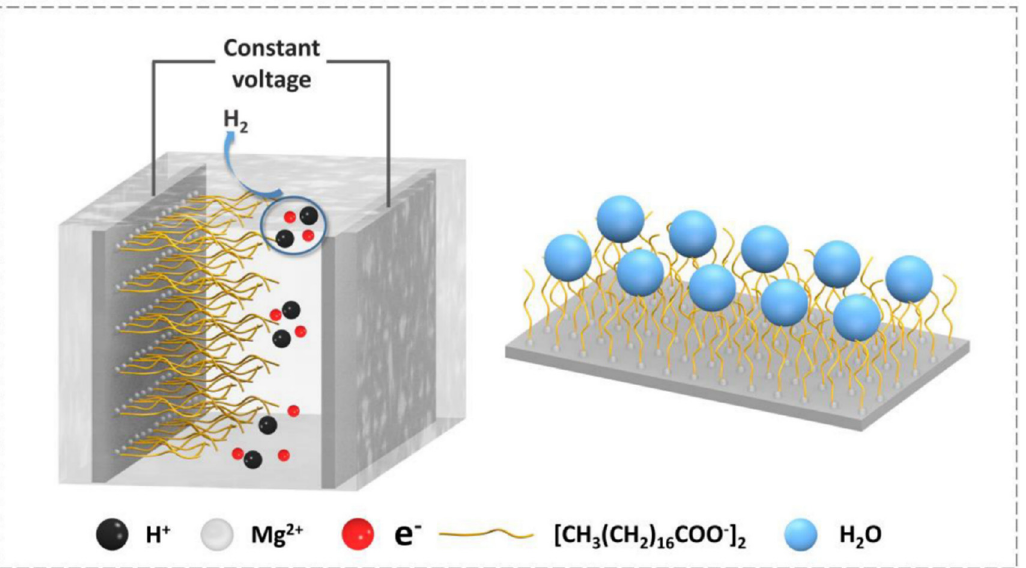
Figure 7. Scheme of the one-step electrodeposition on Mg alloys. Reprinted with permission from Ref. [7]. Copyright (2019) Elsevier.